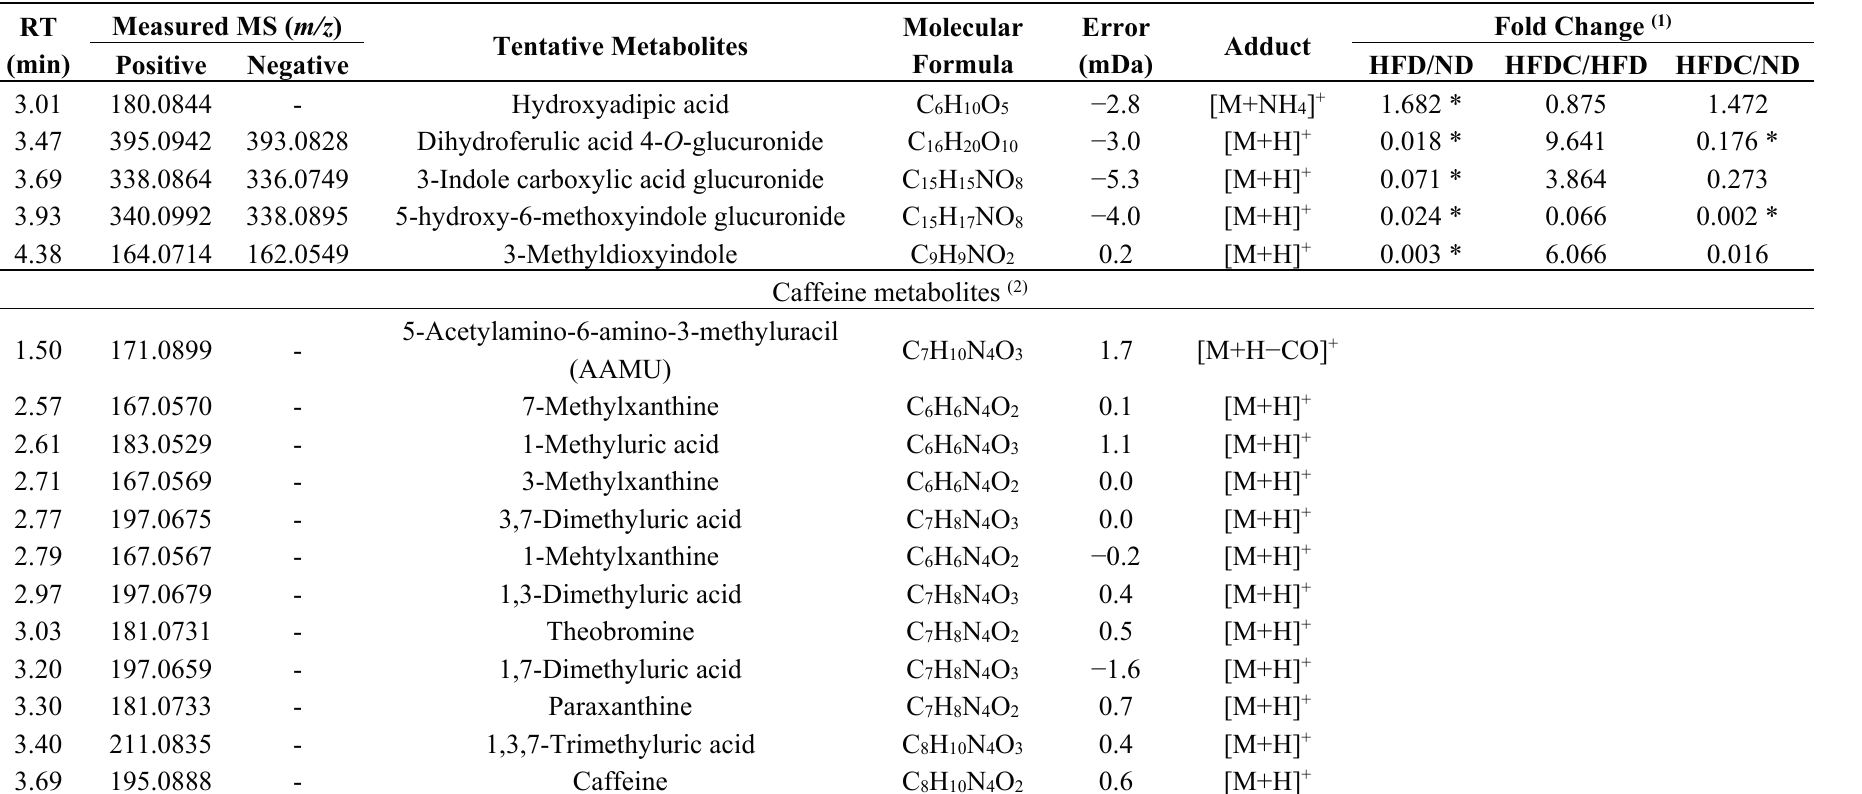
Table 2. Discriminated metabolites of urine identified using